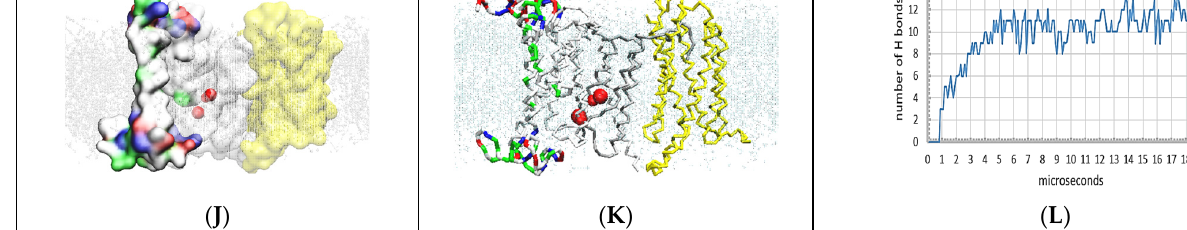
Figure 3. ( A–L ) Multiscale MD studies of docking of the free C99- β CTF-APP substrate to Figure 3. ( A – L ) Multiscale MD studies of docking of the free C99- β CTF-APP substrate to γ (PDB:6IYC, [46] ) shows nicastrin (pink), presenilin 1 (white), and Aph1 and Pen2 (yellow) subu- nits. Red beads depict the active sites Asp257 and Asp 385. The cholesterol–lipid bilayer is shown